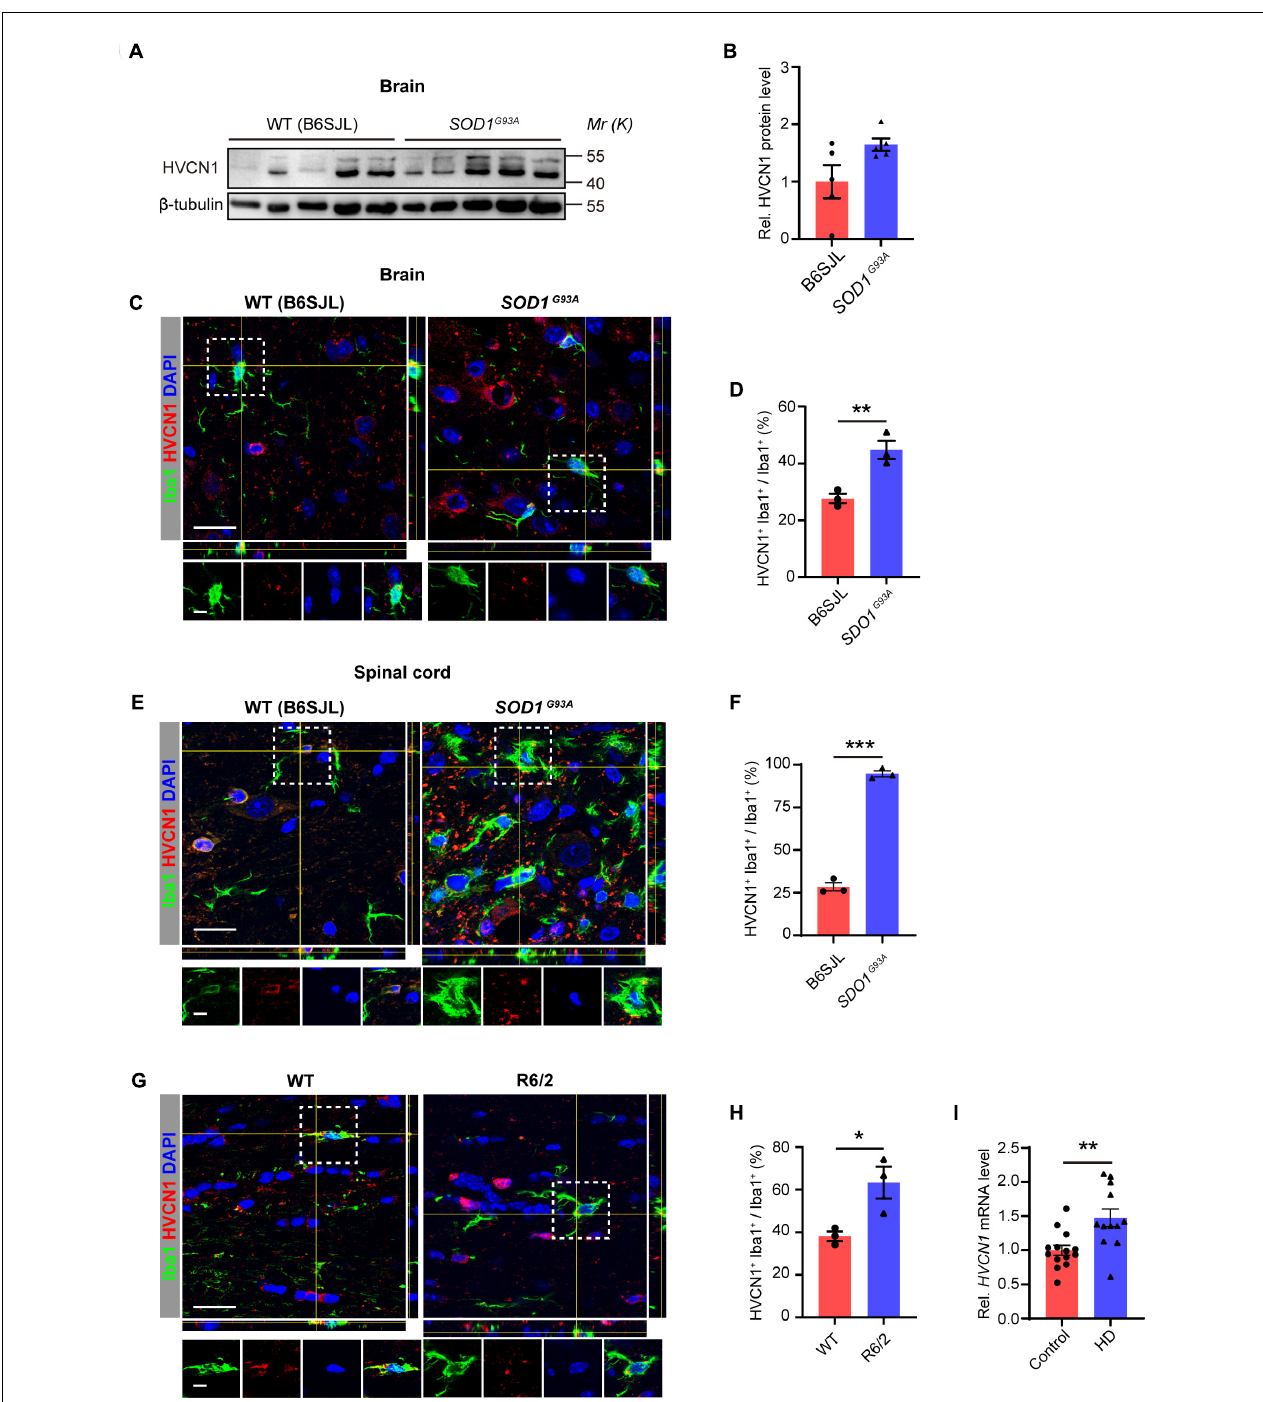
FIGURE 3 | Upregulation of HVCN1 in microglia/macrophage in neurodegenerative diseases of the central nervous system. (A,B) Representative Western blot images (A) and quantification of densities (B) of HVCN1 in the whole brain of SOD1 G 93 A mice and their littermates B6SJL mice ( n = 5). (C–F) Representative immunofluorescence images (C,E) and quantification of the proportion (D,F) : HVCN1 (red) is expressed in Iba1 + microglia/macrophages (green) in the brain (C,D) and the spinal cord (E,F) of SOD1 G 93 A mice and their littermates B6SJL mice ( n = 3). (G,H) Representative immunofluorescence images (G) and quantification of the proportion (H): HVCN1 (red) is expressed in Iba1 + microglia/macrophages (green) in the brain of wild type (WT) and R6/2 mouse ( n = 3). (I) HVCN1 mRNA level in the peripheral blood of patients with Huntington’s Disease ( n = 14) in comparison with the healthy control subjects ( n = 12) (Borovecki et al., 2005). Scale bars (C,E,G) = 20 µ m; the side length of the dashed-line square = 5 µ m. Data are presented as mean ± SEM. Statistical tests: unpaired two-tailed t -test (B,D,F,H,I) ; * p < 0.05, ** p < 0.01, *** p < 0.001.